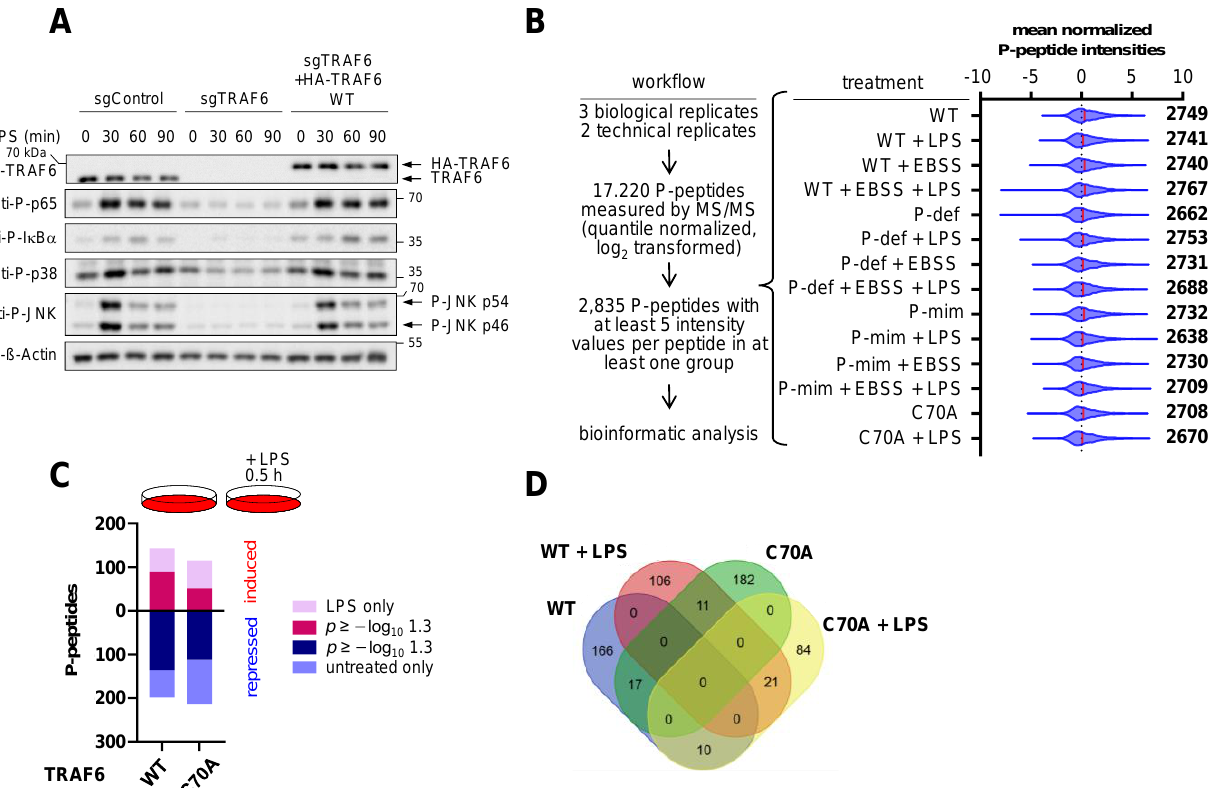
Figure 6. Analysis of LPS-induced TRAF6-dependent phosphorylation networks. ( A ) The indicated cells, either expressing endogenous TRAF6, deleted in TRAF6 or reconstituted to express TRAF6 in fusion with a C-terminal tandem HA tag, were stimulated for various time periods with LPS. Cell extracts were analyzed for basal and LPS-inducible phosphorylation of signaling proteins with specific antibodies, as shown. Note that the tandem HA tag increases the molecular weight of TRAF6. ( B ) Schematic display of the experimental setup and cell treatment. EBSS treatment was always performed for 5 h and LPS treatment for 30 min. Cells experiencing consecutive EBSS and LPS treatment were allowed to recover for 30 min following starvation. The subsequent LC-MS/MS workflow is indicated. The Violin plots show total numbers and mean normalized phosphopeptide intensities under the various conditions. ( C ) The top shows the experimental design; the lower part shows the number of phosphopeptides that were increased or decreased after LPS stimulation in TRAF6 WT or TRAF6 C70A expressing cells. We separately show regulated peptides where a p -value could not be calculated due to the fact that phosphorylation was not occurring/detected in at least one of the samples. ( D ) The Venn diagram shows a comparison of phosphopeptides (up- or downregulation) determined in unstimulated or LPS-treated cells expressing TRAF6 WT or TRAF6 C70A.